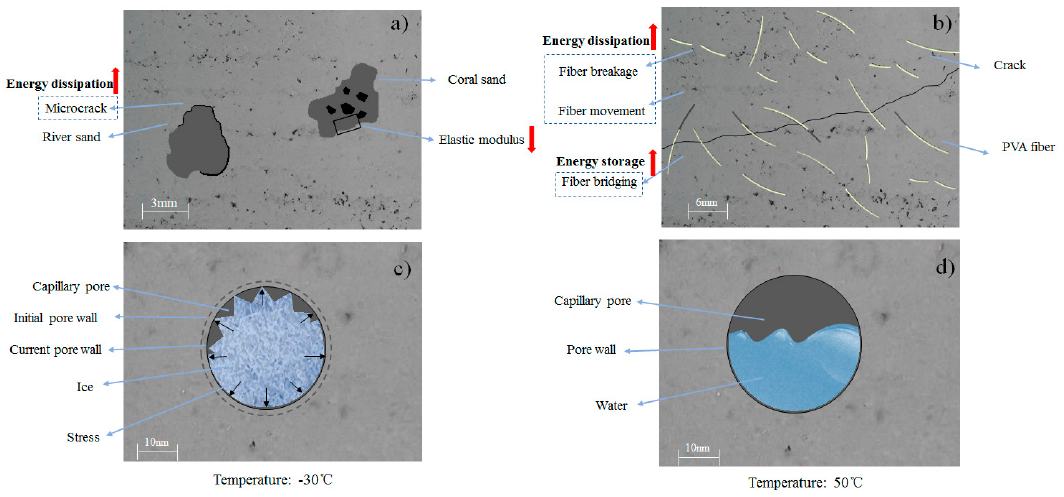
Figure 11. Schematic diagram of the reinforcing mechanism on dynamic mechanical properties of marine mortar: ( a ) Coral sand aggregate replacement; ( b ) PVA fiber reinforcement; ( c ) after cooling process ( − 30 °C < T < 0 °C); ( d ) after heating process (0 °C < T < 50 °C).